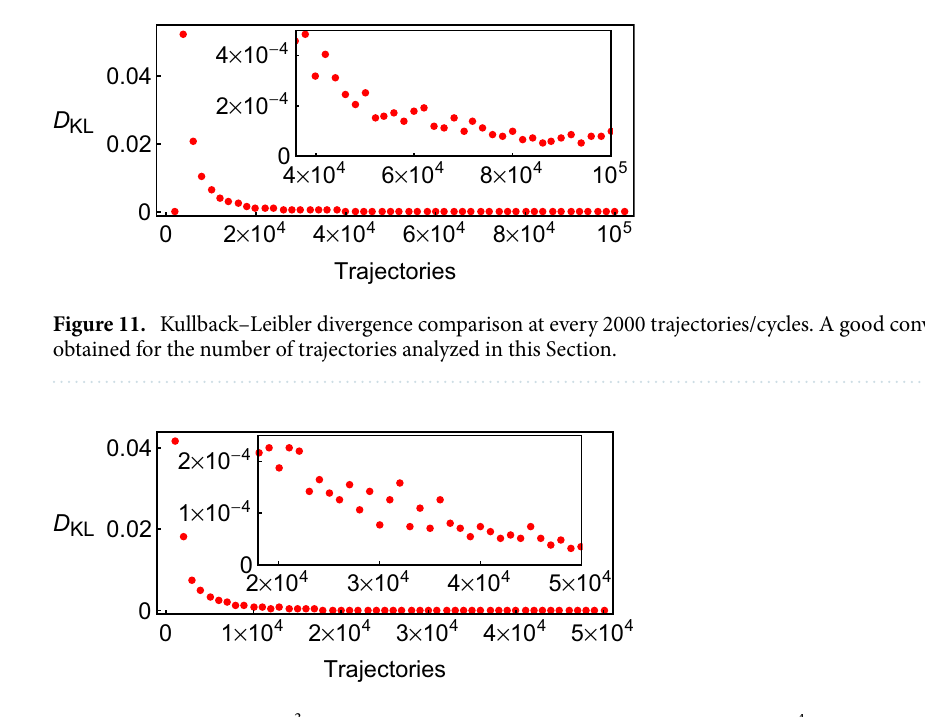
Figure 12. D KL at every 10 3 trajectories/cycles. Convergence is considered at 5